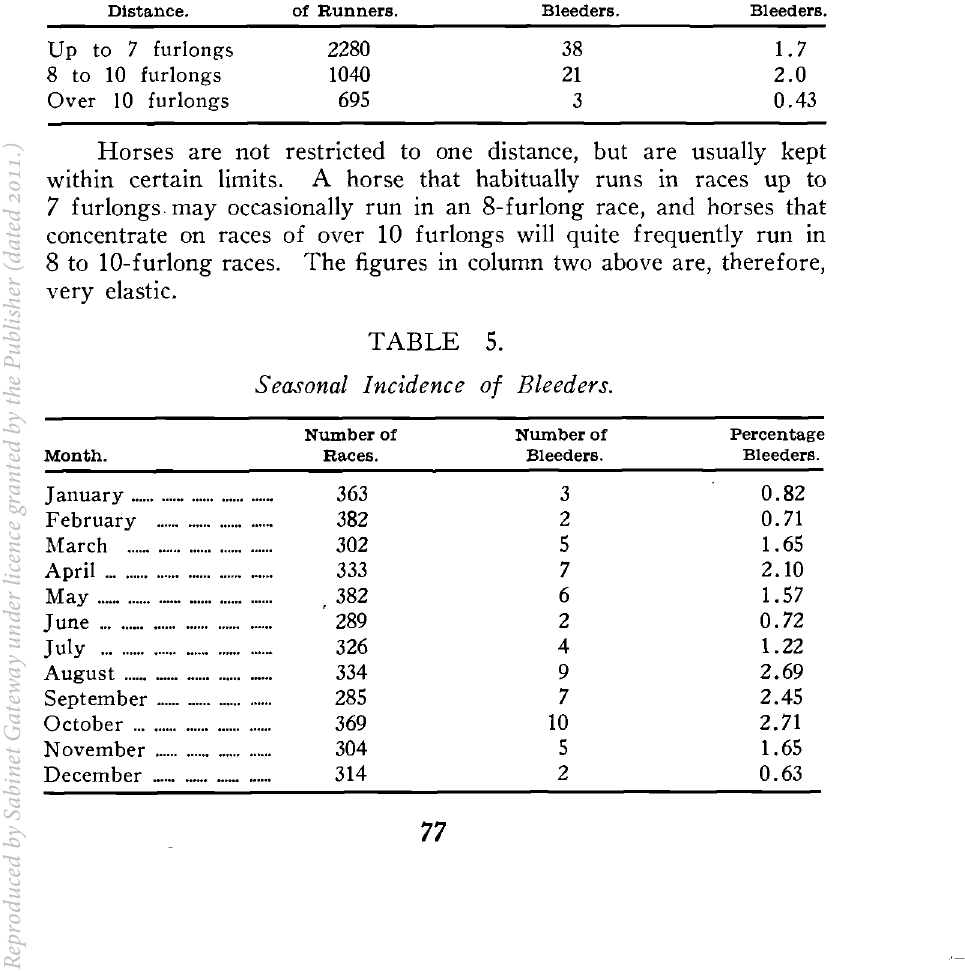
4(b ). Distance Incidence of Bleeders. Approximate Number Number of Percentage Distance. Bleeders. Bleeders.